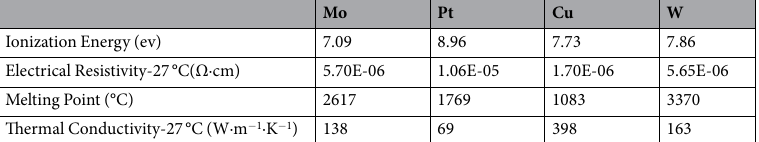
Table 1. Physical characteristics of electrode material.